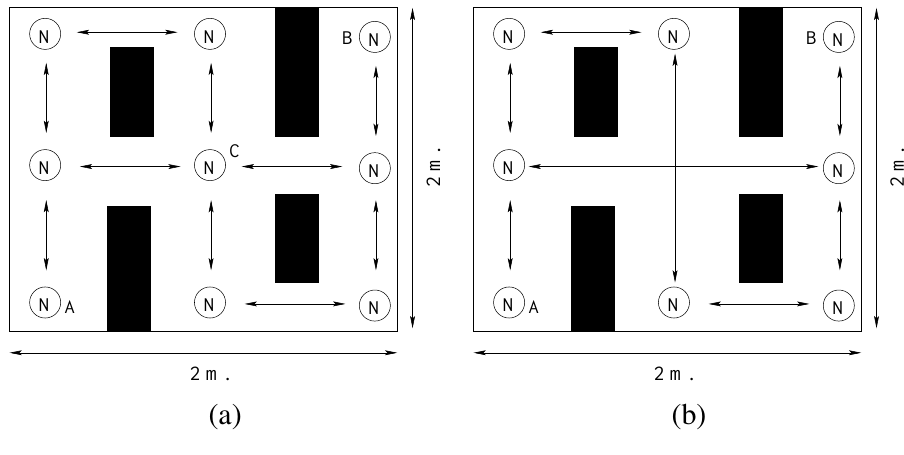
Figure 19. Nodes sharing information about the estimated location of node A.